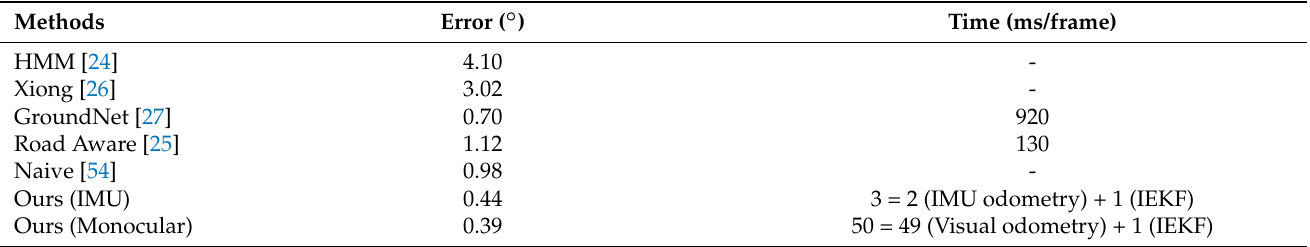
Table 2. Quantitative comparison of our proposed method with previous works. The running time is also compared here to demonstrate the improvement in efficiency using our method. Particularly, the adopted IEKF takes less than one millisecond per